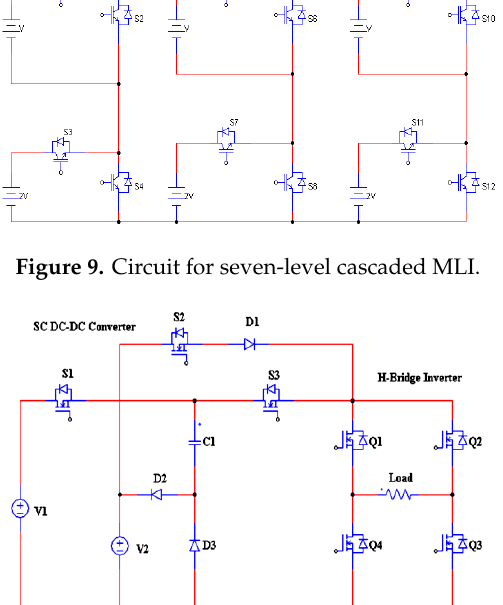
Figure 10. MLI based on switched capacitor.